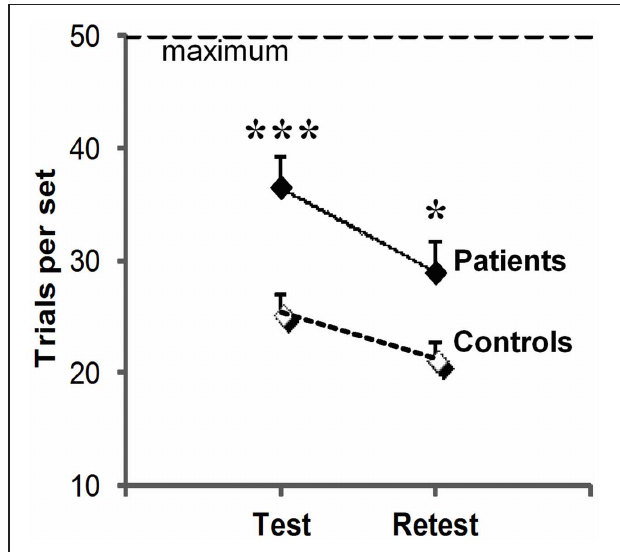
FIGURE 2 | Global learning impairment in PD patients relative to controls. Number of trials (trials per set, mean, and SEM) to reach or fail to reach criterion of three consecutive correct responses for all 3 associations within the imparted 50 trials (maximum) on the test and retest session; the higher the scores, the worse the performance. For each session, scores were averaged over three trios of visuo-motor associations ( ∗∗∗ p = 0 . 001; ∗ p = 0 . 05: between group differences as revealed by two-sample t